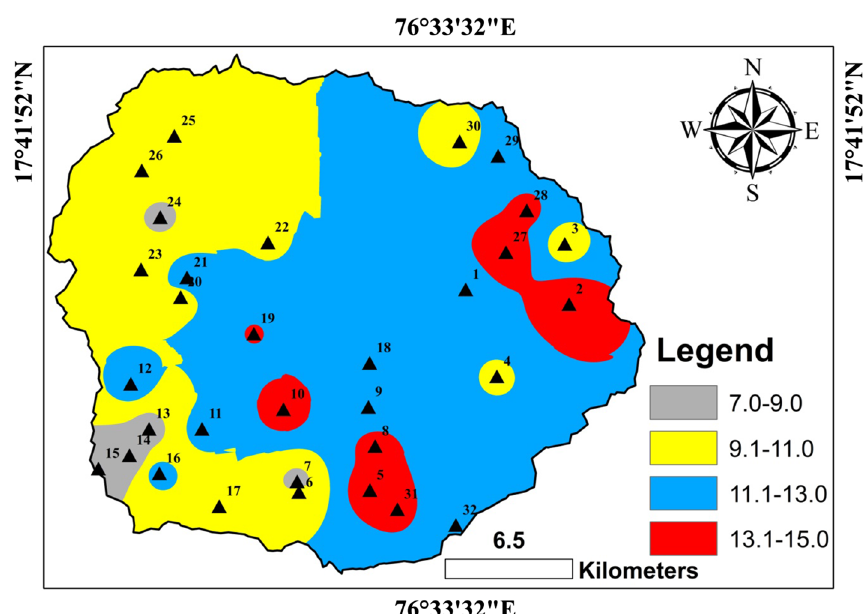
Fig. 13 Geospatial distribution of sodium